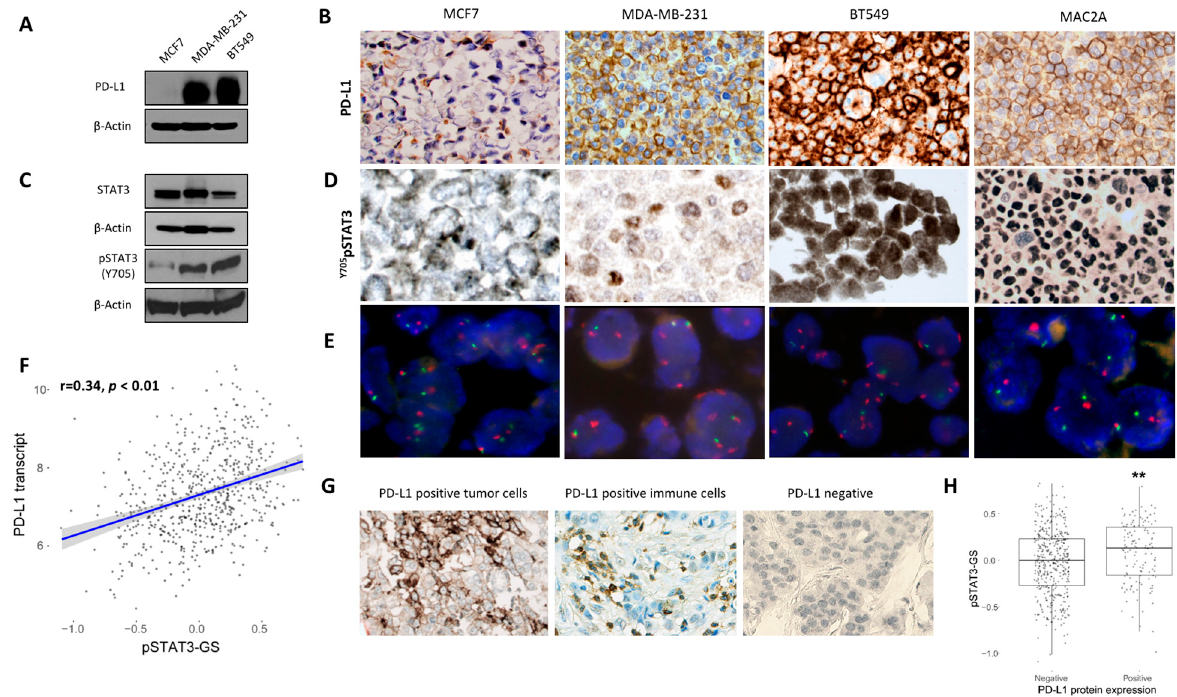
Figure 1. Expression of PD-L1 and STAT3 in breast cancer cell lines and in breast cancer patients. ( A ) Expression of PD-L1 protein in breast cancer cell lines in immunoblots. ( B ) Immunohistochemical expression of PD-L1 in breast cancer cell lines using FFPE cell blocks. ( C ) Protein expression of STAT3 and STAT3 phosphorylation at Tyr705 (Y705) residue in immunoblots in breast cancer cell lines. ( D ) Immunohistochemical expression pSTAT3 (Y705) in breast cancer cell lines using FFPE cell blocks. The anaplastic large cell lymphoma cell line Mac2A was used as a positive control. Original magnification: 400×. ( E ) Fluorescence in situ hybridization (FISH) analysis for PD-L1 probe performed on FFPE cell blocks. The validated probe (green signal) covers the gene locus at 9p24.1. A centromeric chromosome 9 probe (CEN9, red signal) was used as a control. No PD-L1 gene amplification was demonstrated in Mac2A cell line. Original magnification: 630×. ( F ) Correlation of PD-L1 transcript expression with a previously published pSTAT3-associated gene signature (pSTAT3-GS) reflecting the status of pSTAT3 expression in breast cancer patients with available gene expression profiling data ( n = 619). ( G ) PD-L1 expression was evaluated in human breast cancer samples using immunohistochemistry in tissue microarrays. Representative patient cases with positive expression in tumor cells (left panel), immune cells (middle panel) and negative expression (right panel) are shown. Original magnification: 400×. ( H ) Correlation between samples with positive and negative PD-L1 protein expression on either tumor or immune cells (total cells) with pSTAT3-GS in breast cancer patients ( n = 539, Wilcoxon-Mann-Whitney test, p = 0.0027, ** p < 0.01 ).